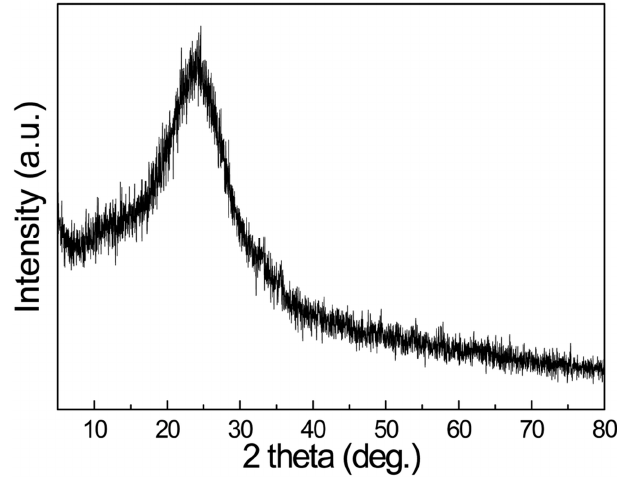
Figure 3. XRD pattern of Pure PPy prepared at 30 °C.